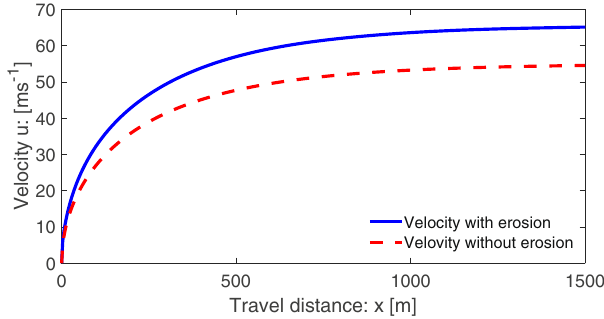
Fig. 3 Evolution of the landslide velocity as a function of travel distance with and without erosion given by (25). Erosion enhances the landslide velocity and thus its